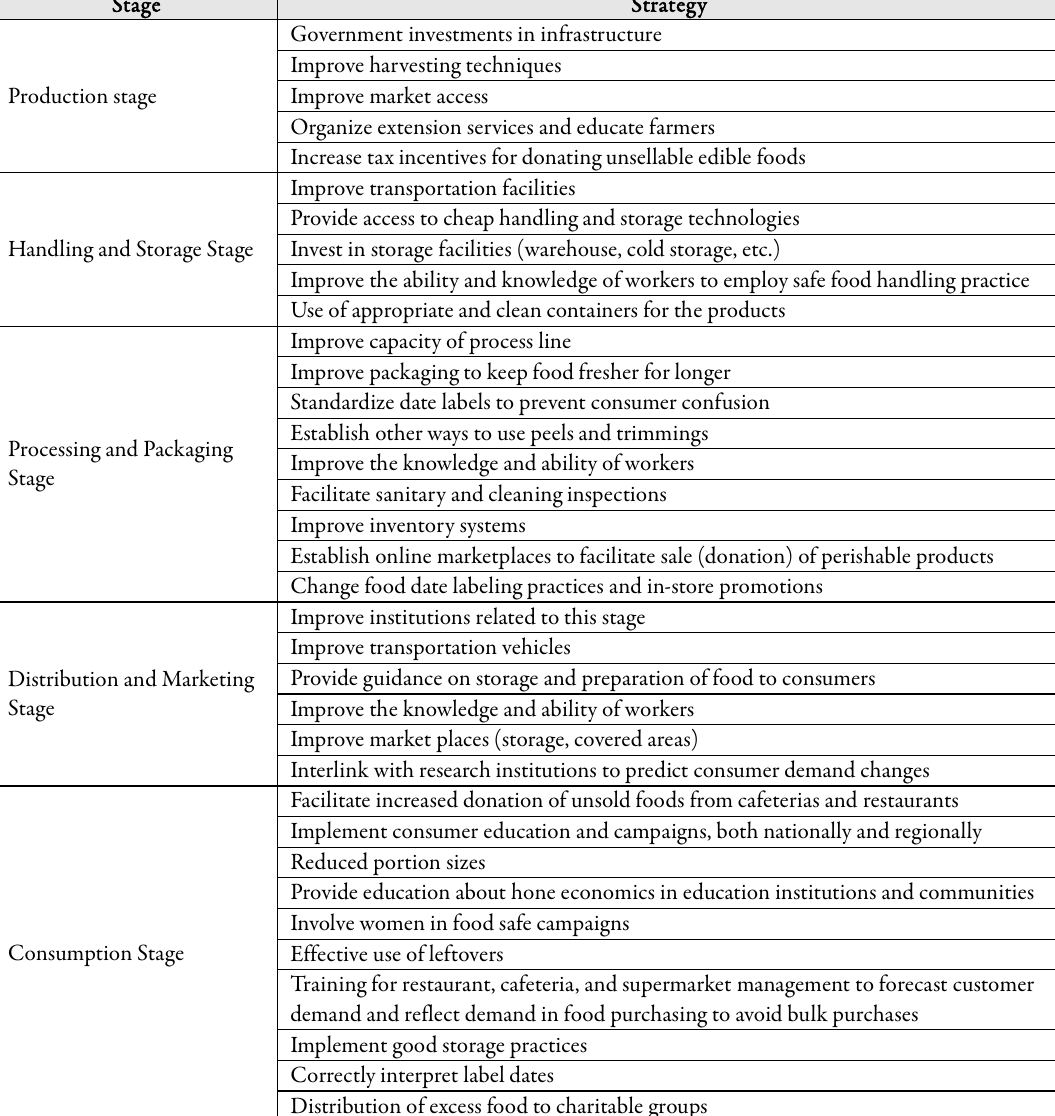
Table 2. Possible strategies to prevent the food loss and waste (FLW) at different stages of food supply chain (FSC) (Ishangulyyev et al .,